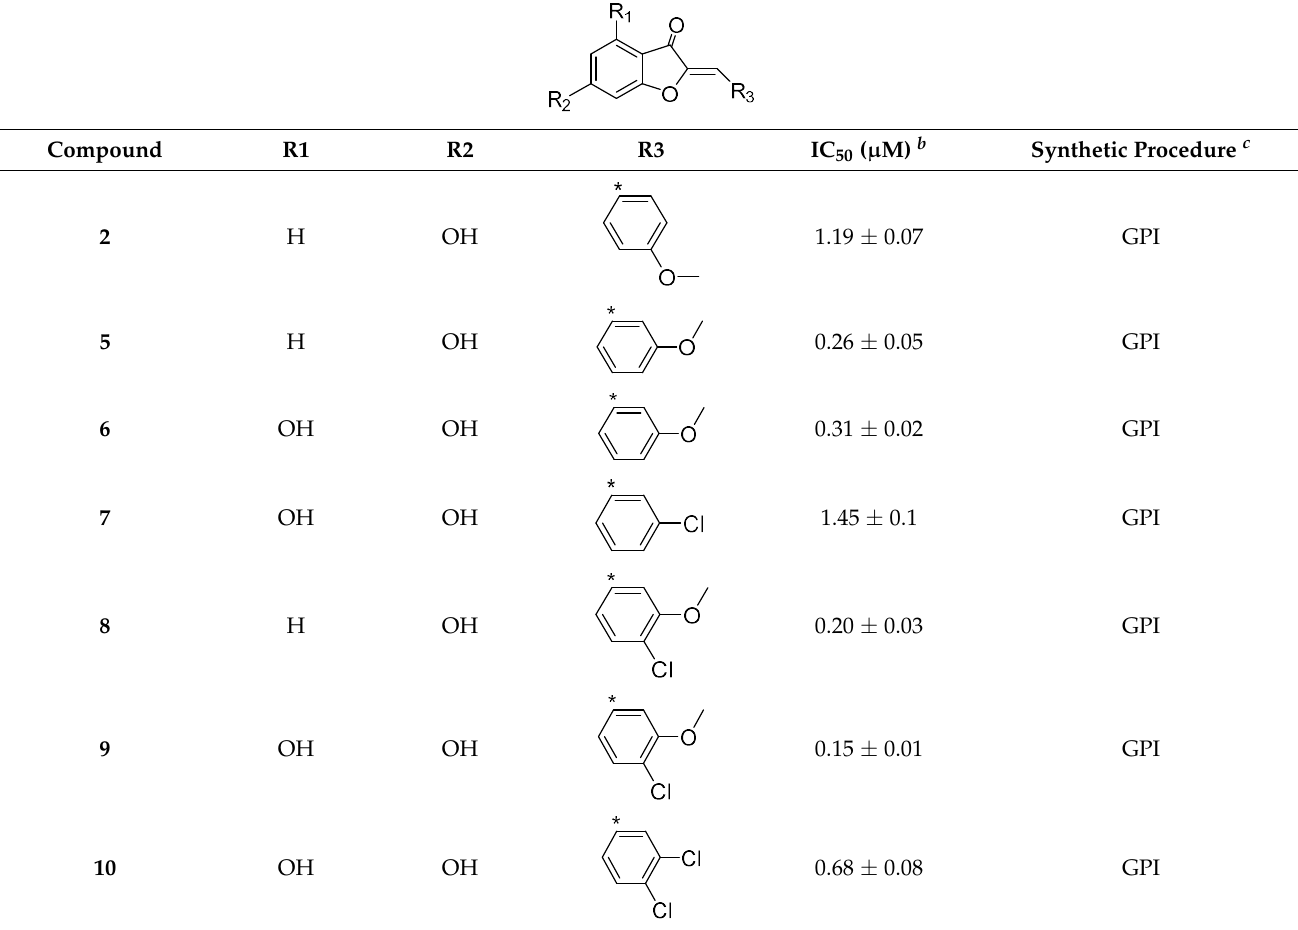
Compound Compound Compound